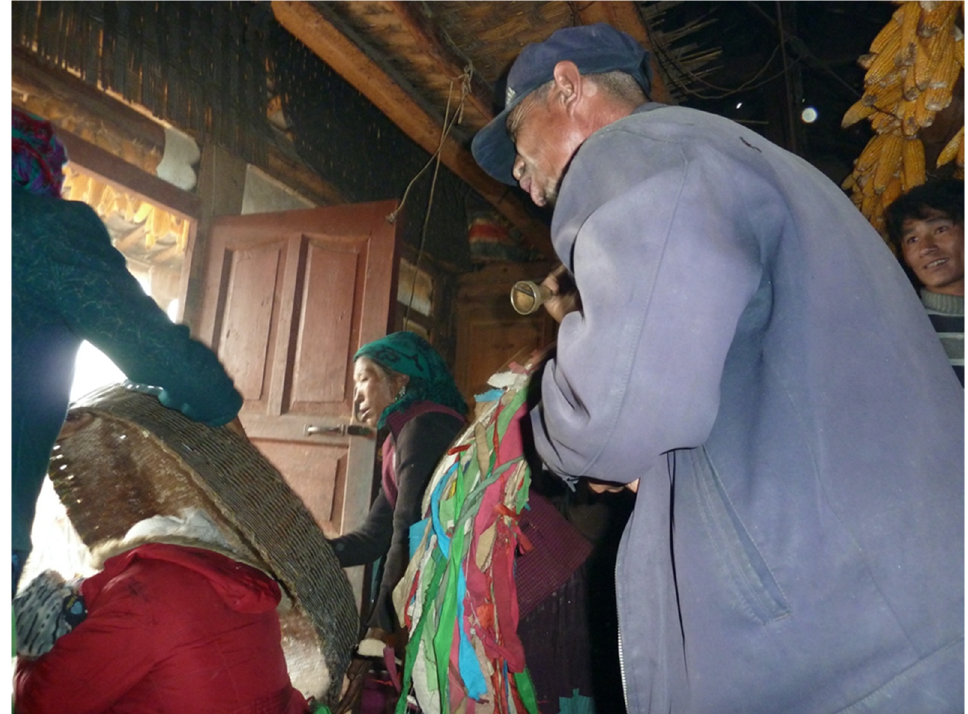
Figure 5. A Nuosu shaman holds a brass bell with a bundle of knotted ribbons attached to it while standing behind his clients, some of whom are seated by the household threshold beneath a large winnowing basket that is held over them to protect them from ghosts. The shaman chants and expels ghosts during an exorcism in Niplat, 2011. Photograph by the author.